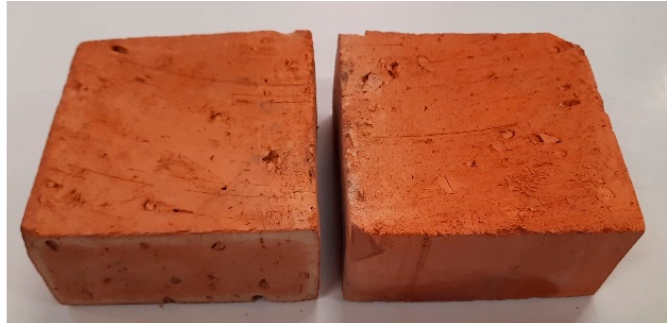
Figure 1. A brick sample used for tests. Table 2. Quality parameters of ceramic building materials produced from the local Pliocene clay